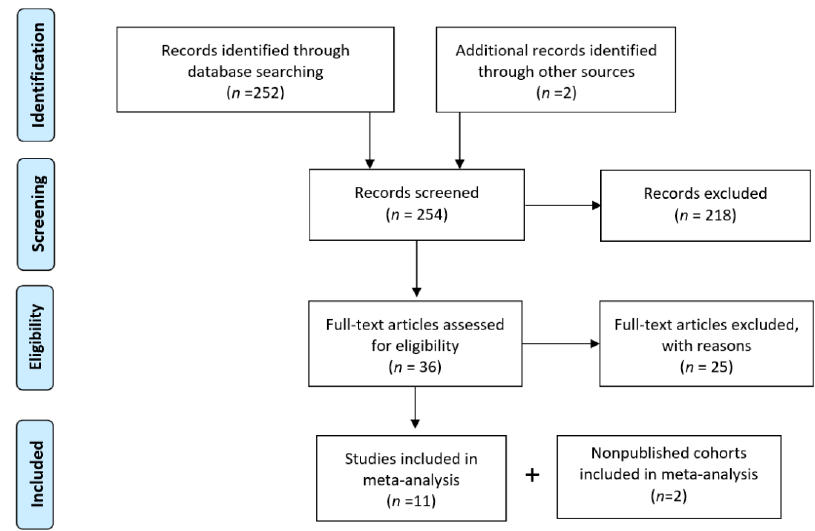
Figure 3. Flowchart summarizing the literature selection process for the systematic literature revision and meta-analysis of BiP immunohistochemistry in breast cancer.